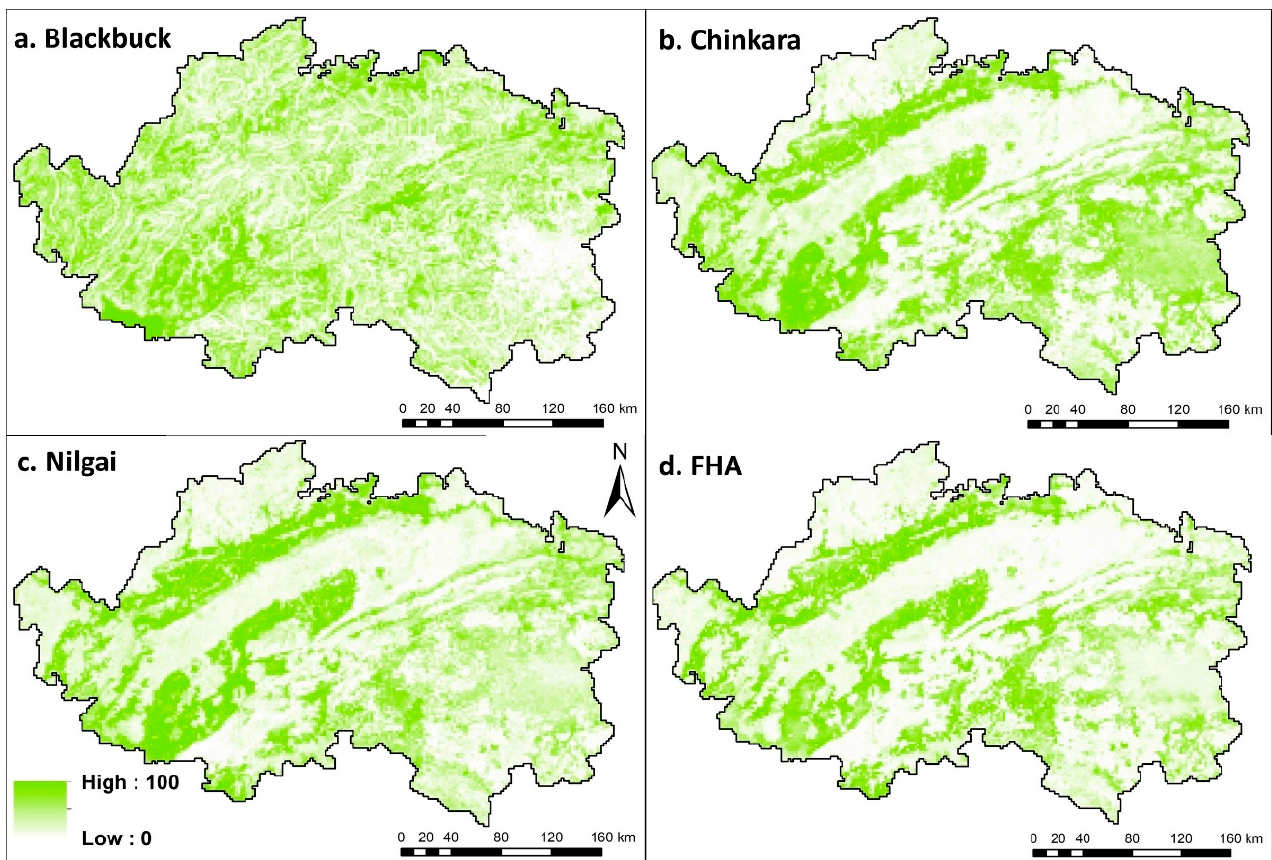
Figure 5. Habitat suitability ensemble output maps for all 4 focal species. FHA is four-horned antelope. ( a ) Blackbuck; ( b ) Chinkara; ( c ) Nilgai; ( d ) FHA.